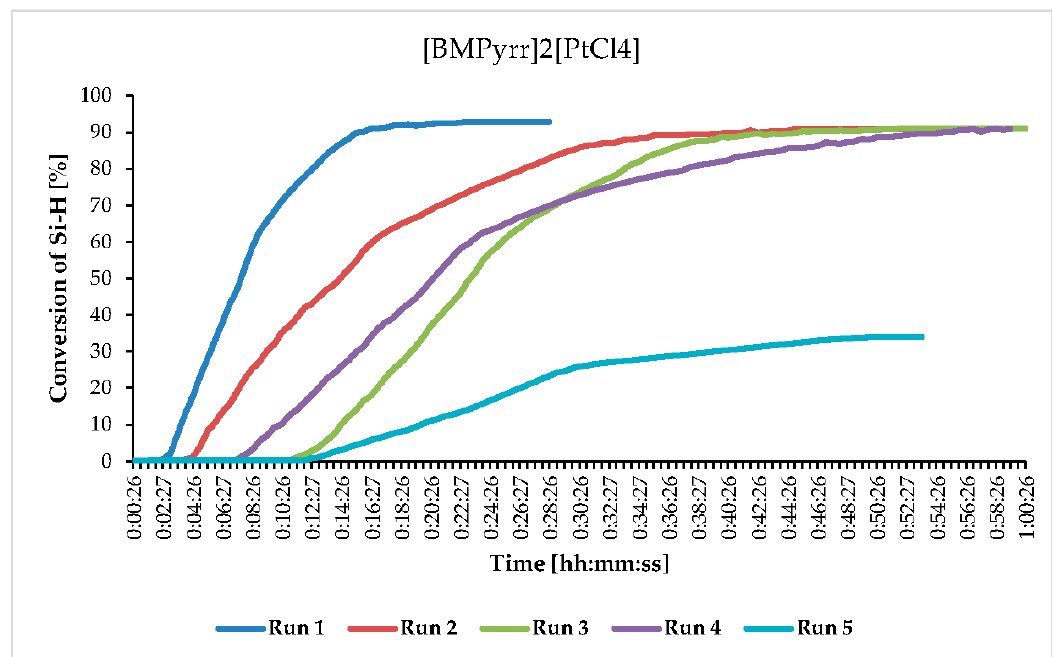
Figure 4. The change in the conversion of ≡ SiH as a function of time for the reaction catalyzed by [BMPyrr] 2 [PtCl 4 ].